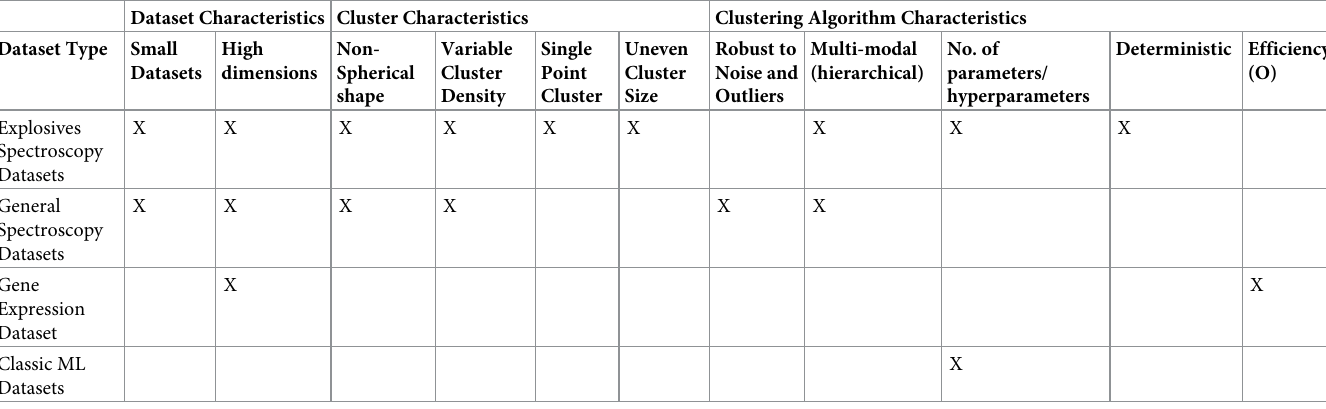
Table 2. Characteristics applicable to the validation